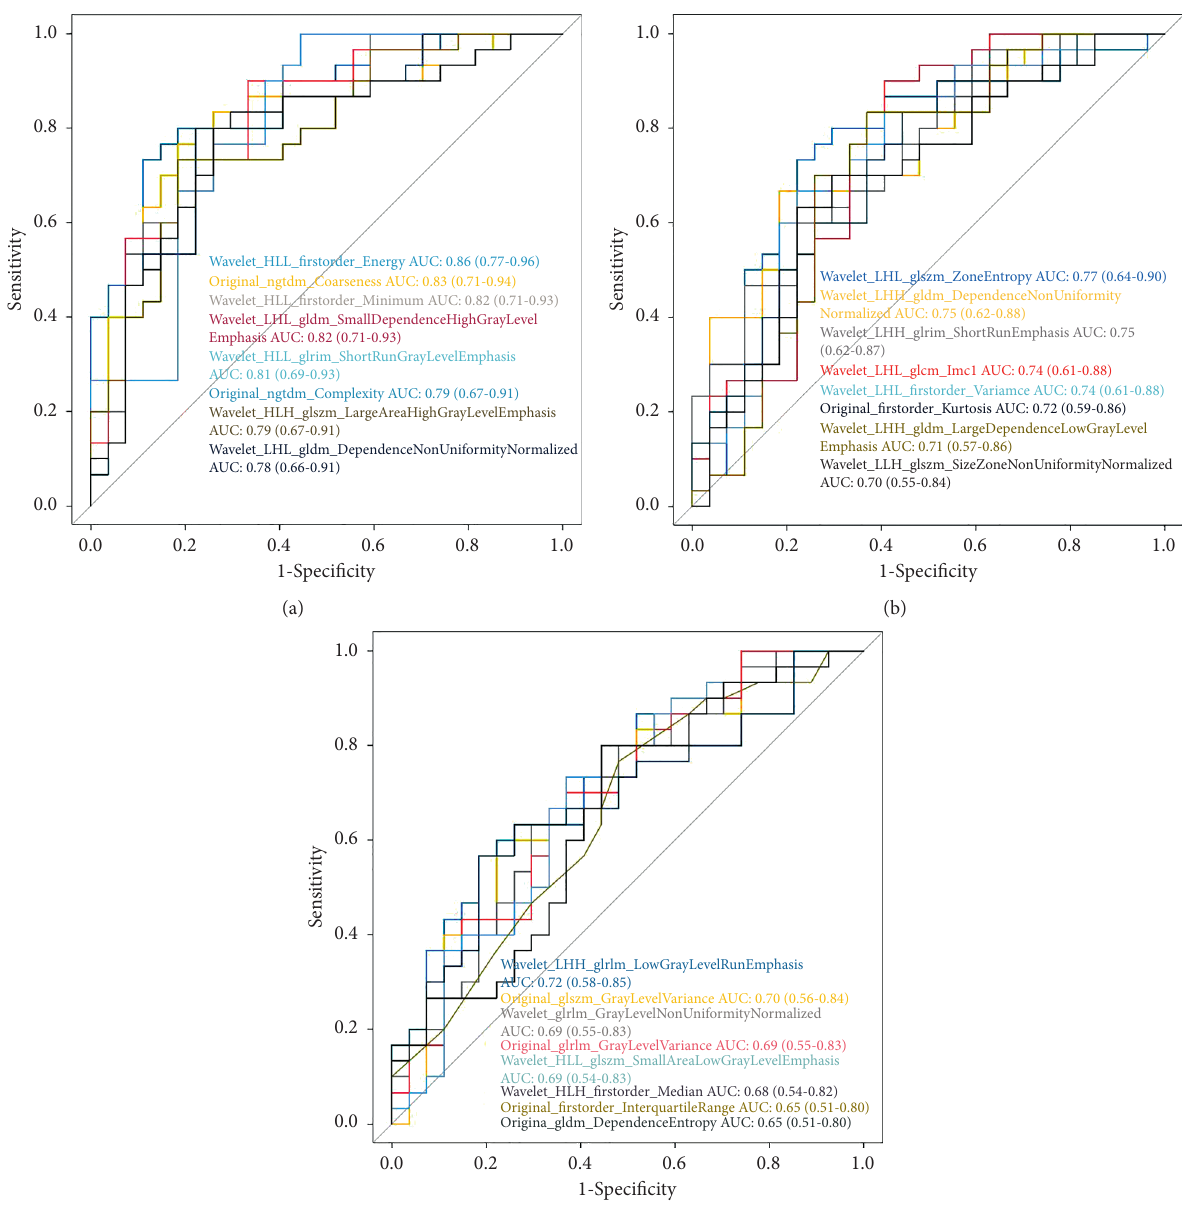
Figure 4: AUC of the selected features with high correlation of each sequence (out-of-phase T1W, in-phase T1W, and